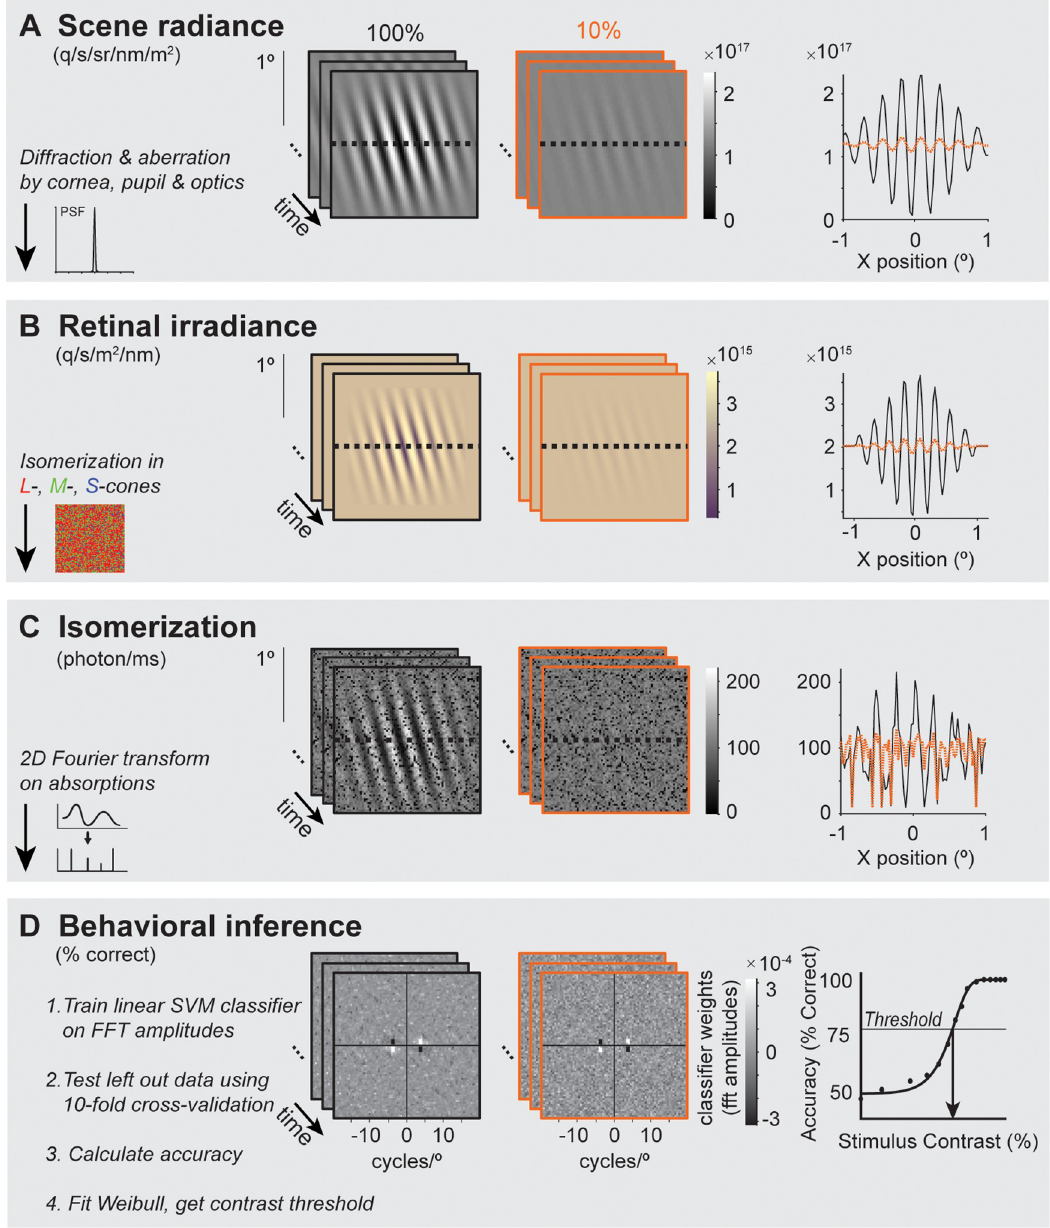
Fig 5. Overview of computations in observer model. Computations are shown for a 100% (black outline) or 10% (orange outline) contrast Gabor stimulus. (A) Scene radiance . The computation starts with the scene spectral radiance of a time-varying scene. The 2D images show the radiance summed across wavelengths (400–700 nm) during 1-ms windows. 1D slices through the images are plotted on the right. (B) Retinal irradiance . The retinal irradiance is the image that has passed through the eye’s optics, before being processed by the retina. The optics are modeled as a typical human wavefront with a 3-mm pupil, indicated by the schematic point spread function (PSF) on the lower left of panel A. For illustration purposes, wavelengths of the 2D representation were converted into RGB values. The yellowing is a result of the spectral filtering by the eye’s optics. (C) Isomerization . The time-varying retinal irradiance is transformed into photon absorptions using a rectangular grid of L-, M- and S-cones. The dark pixels correspond to S- cones (see text for more details). (D) Behavioral inference . The last stage of the computational observer is a simplified decision stage, performing a 2-AFC orientation discrimination task. First, the absorption image at each time point was transformed into the amplitude domain by the Fourier transform. The amplitude images were used to train a linear support vector machine (SVM) classifier using 10-fold cross-validation. The images show an example of the trained classifier weights. The weights are high at locations corresponding to the stimulus frequency (4 cycles/˚) and orientation ( ± 15˚). Once trained, the classifier predicted the left- out data. The cross-validated accuracy was fit by a Weibull function (right part of panel D) to determine the contrast threshold.